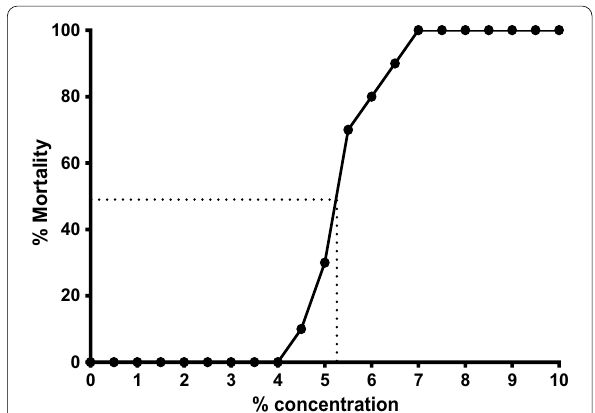
Fig. 1 96-h LC 50 value for Clarias gariepinus fingerlings exposed to varying concentrations of the soap effluent during the period of